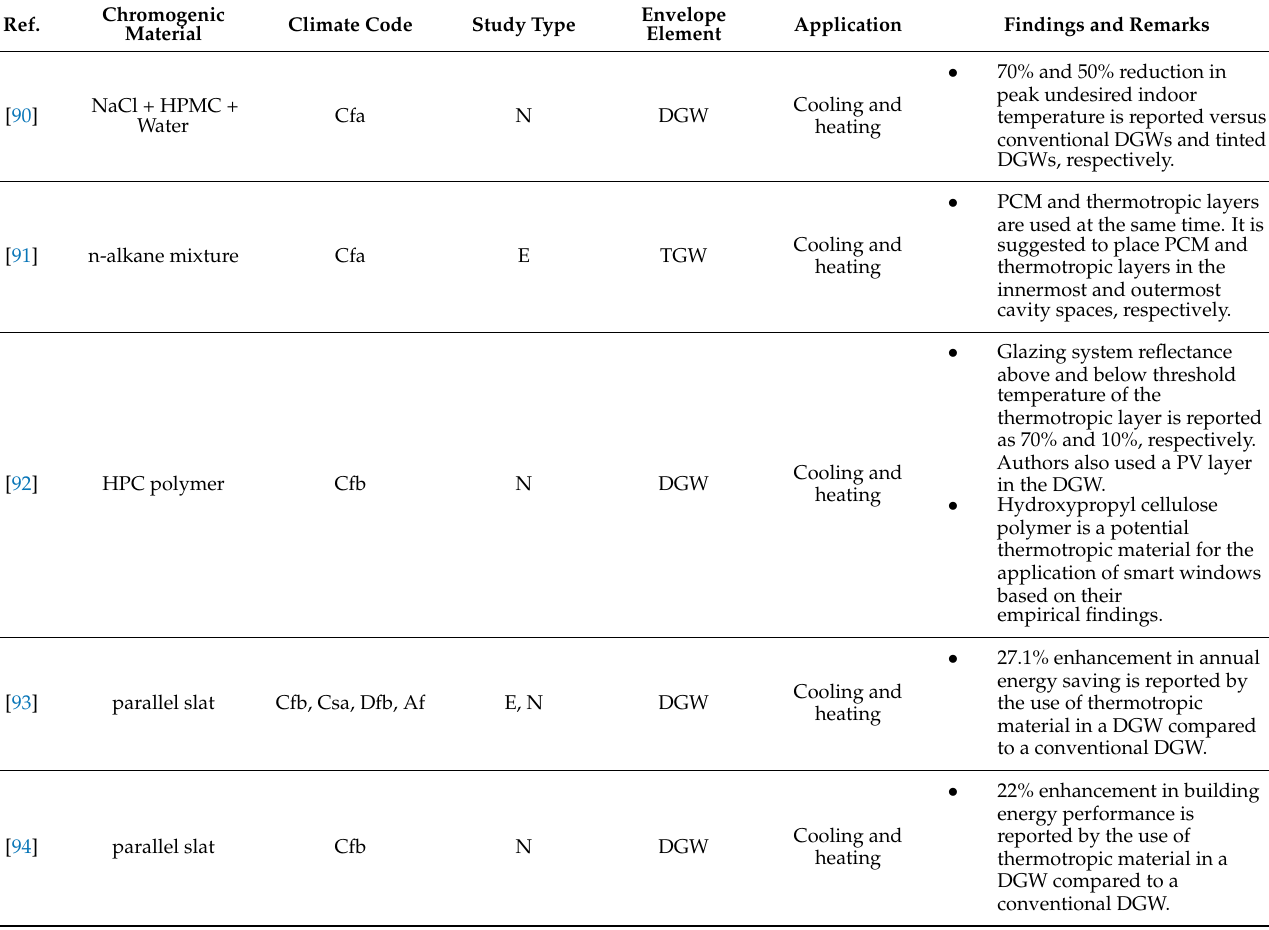
Table 8. Summary of chromogenic (thermotropic and thermochromic) materials in GUs.